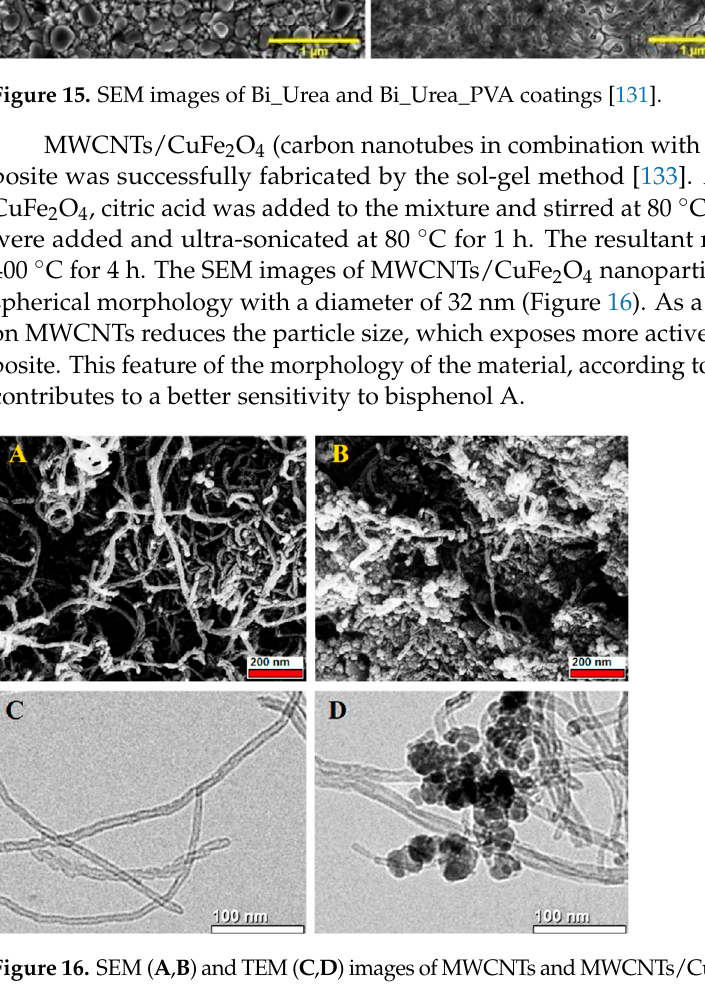
Figure 15. SEM images of Bi_Urea and Bi_Urea_PVA coatings [131].